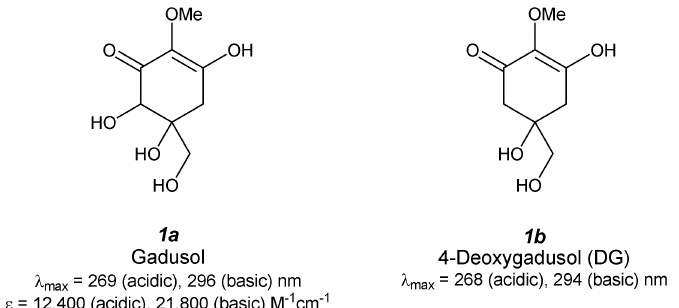
Figure 2. Chemical structure and spectroscopic properties of MAA